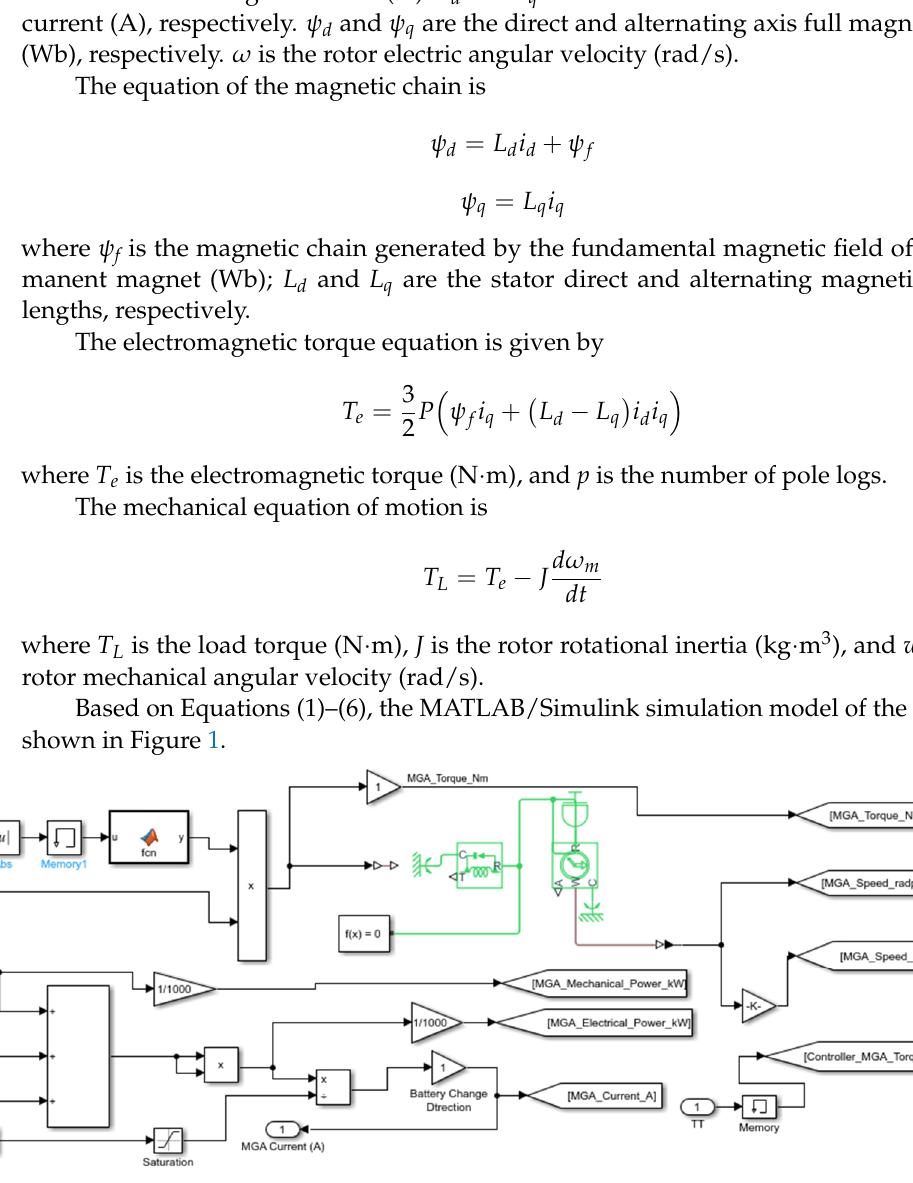
Figure 1. Motor MATLAB/Simulink model.